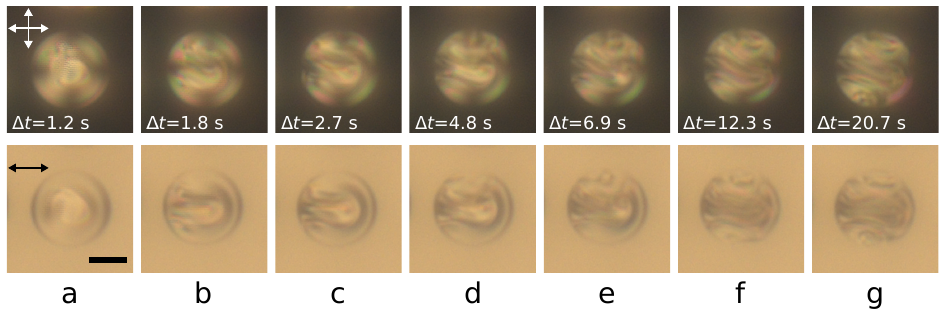
Figure 5. POM images of CLC droplet at N 0 = 7.7 taken with the crossed polarizers ( top row ) and with one polarizer ( bottom row ) ∆ t = 1.2 s ( a ), 1.8 s ( b ), 2.7 ( c ), 4.8 s ( d ), 6.9 s ( e ), 12.3 ( f ) and 20.7 s ( g ) after the voltage was reduced from U reduc . = 5 V ( E reduc . = 0.25 V/ µ m) to U reduc . = 4 V ( E reduc . = 0.20 V/ µ